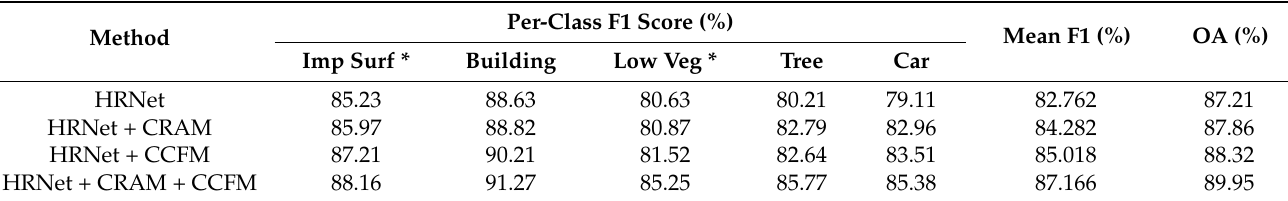
Table 1. Ablation Study Result of different modules in the Potsdam Dataset.